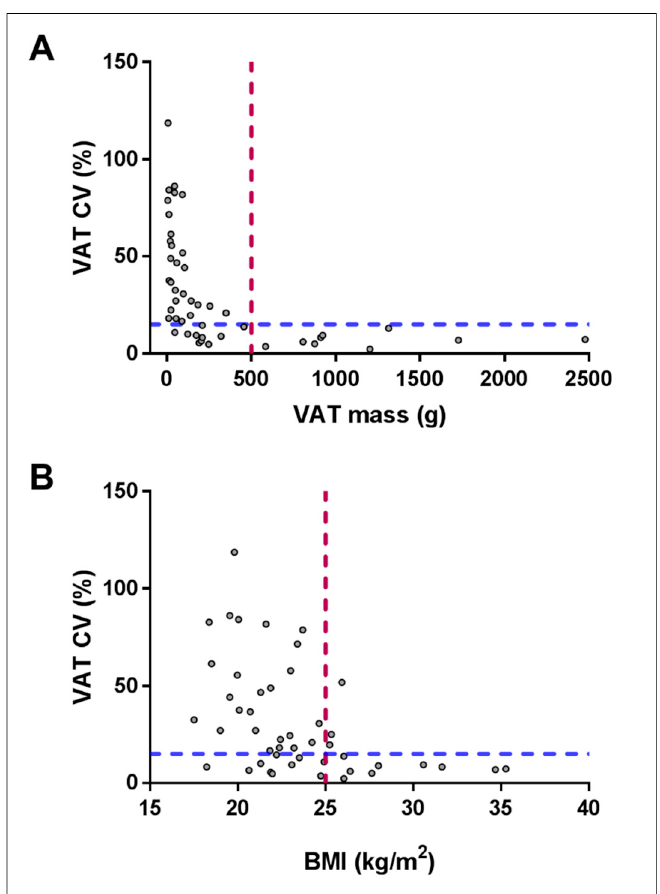
Figure 2. Correlation scatterplot between visceral adipose tissue (VAT) mass coefficient of variation (CV%) and ( A ) VAT mass (g) r s = − 0.795, p < 0.001; and ( B ) body mass index (BMI) (kg/m 2 ) r s = − 0.537, p < 0.001. The dashed lines represent the cut off lines for VAT (500 g) and BMI (25 kg/m 2 ) to increase the probability of more reliable CV% for VAT assessments.